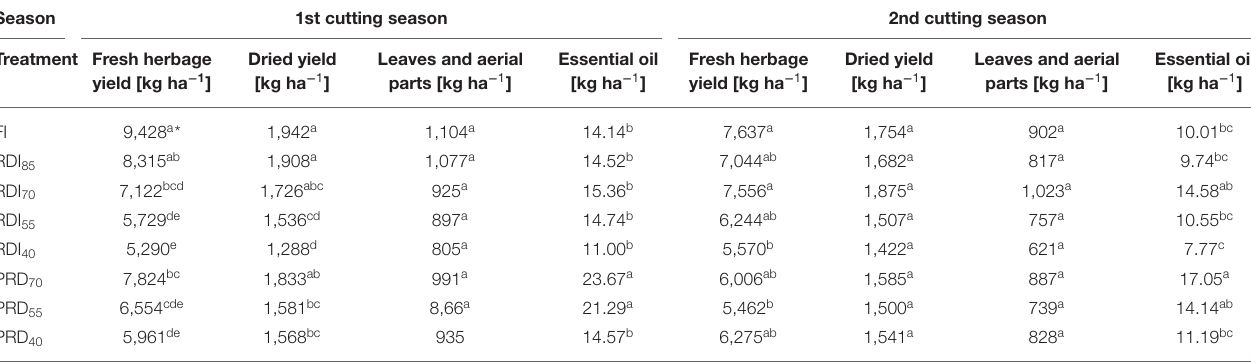
TABLE 1 | Effect of deficit irrigation management on fresh herbage yield, dried yield, leaves and aerial parts weight, and essential oil yield of peppermint in the 1st and 2nd cutting seasons. Season